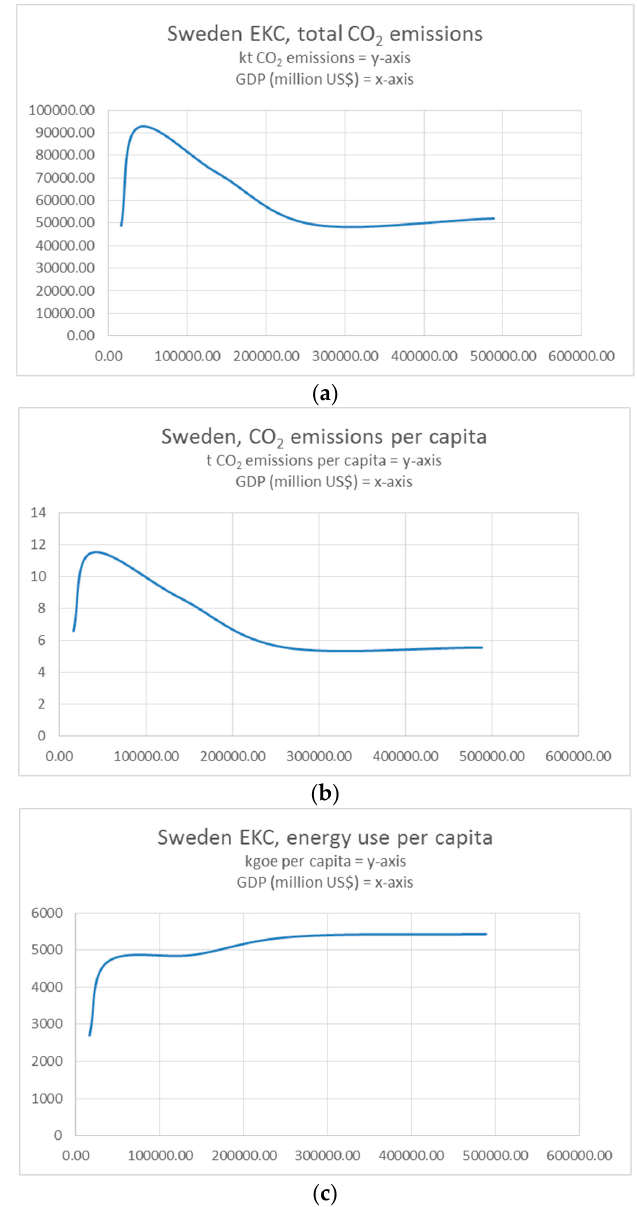
Figure 9. Analysis of the EKC for Norway. Data source: [44]. ( a ) Sweden EKC, total CO 2 emissions; ( b ) Sweden EKC, CO 2 emissions per capita; ( c ) Sweden EKC, energy use per capita.